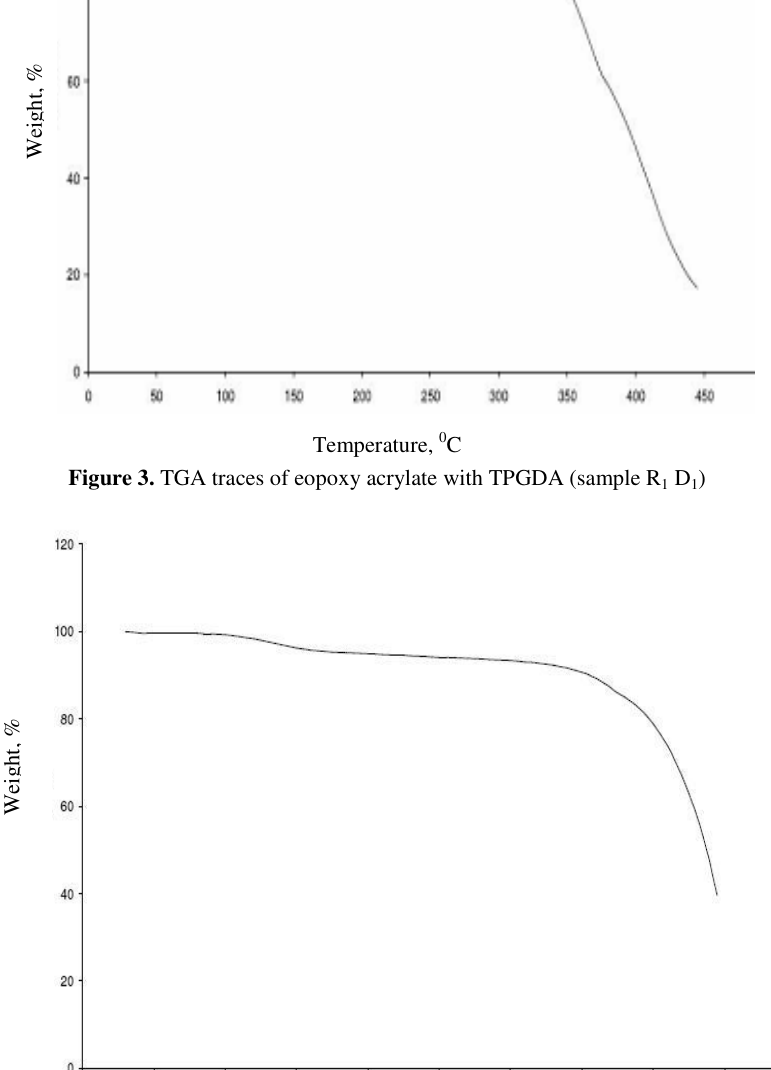
Figure 4. TGA traces of eopoxy acrylate with TMPTA (sample R